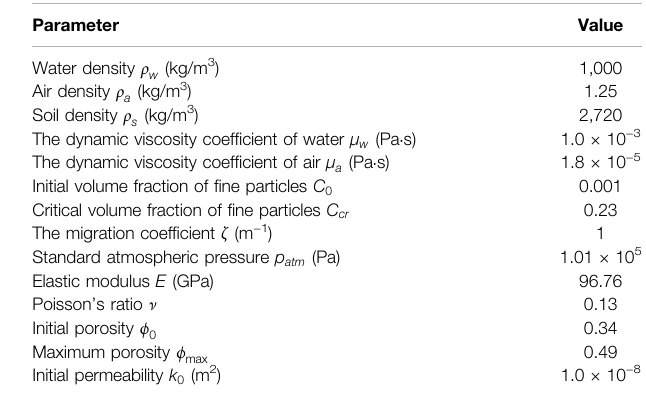
TABLE 1 | Physical parameters of the soil (Sterpi,